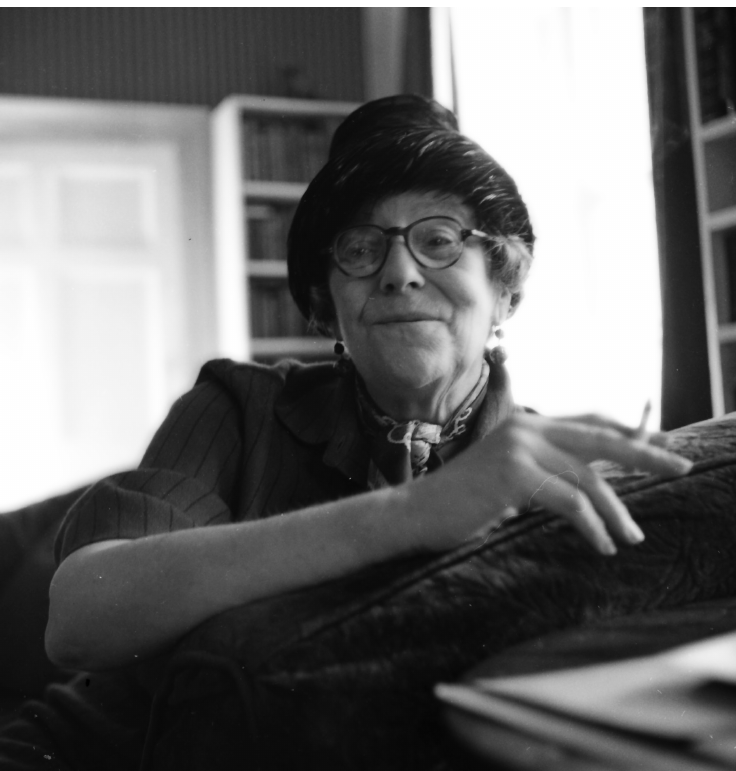
Figure 1 Sylvia Townsend Warner at the Old Rectory, Litton Cheney. Image courtesy of the Estate of Reynolds and Janet